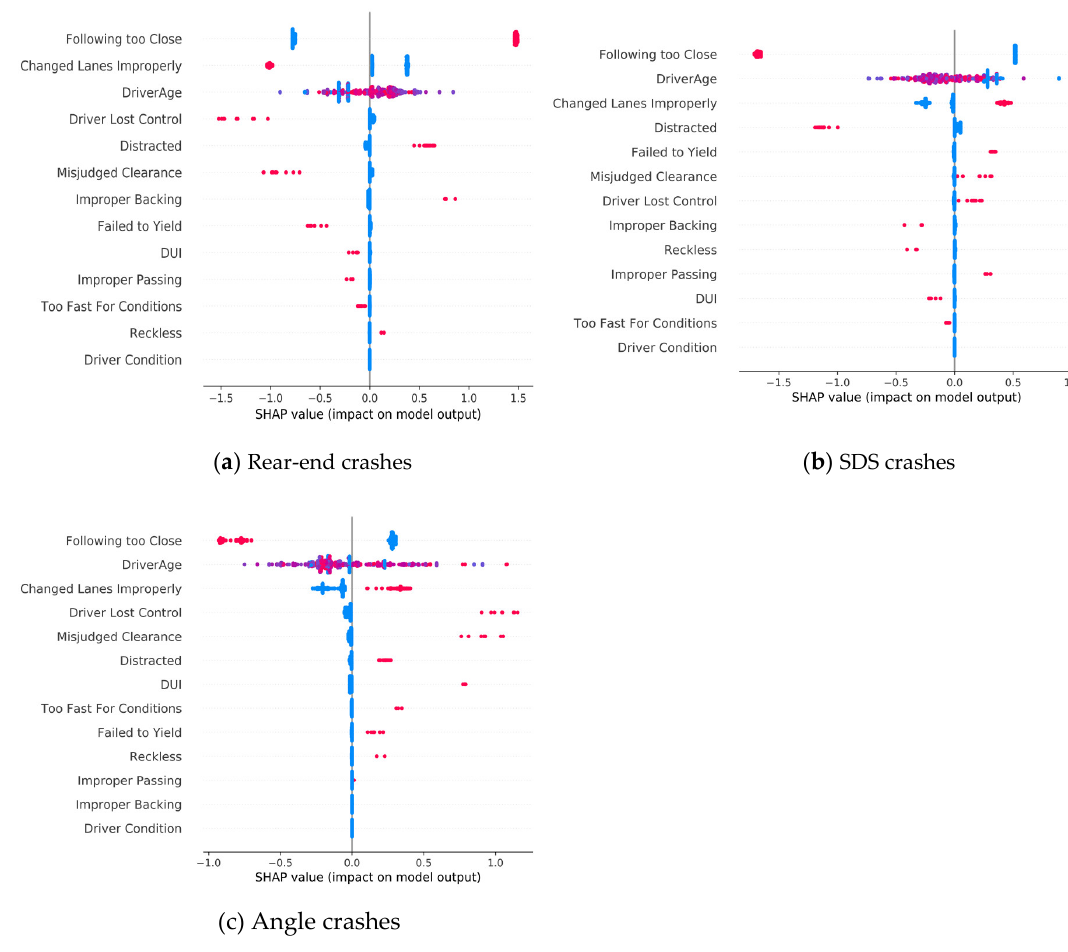
Figure 12. Effects of driver-related features; (a) SHAP value plot for rear-end crashes, (b) SHAP Figure 12. E ff ects of driver-related features; ( a ) SHAP value plot for rear-end crashes, ( b ) SHAP value value plot for SDS crashes, (c) SHAP value plot for angle crashes (note: red indicates high feature plot for SDS crashes, ( c ) SHAP value plot for angle crashes (note: red indicates high feature value and value and blue indicates low feature value). blue indicates low feature